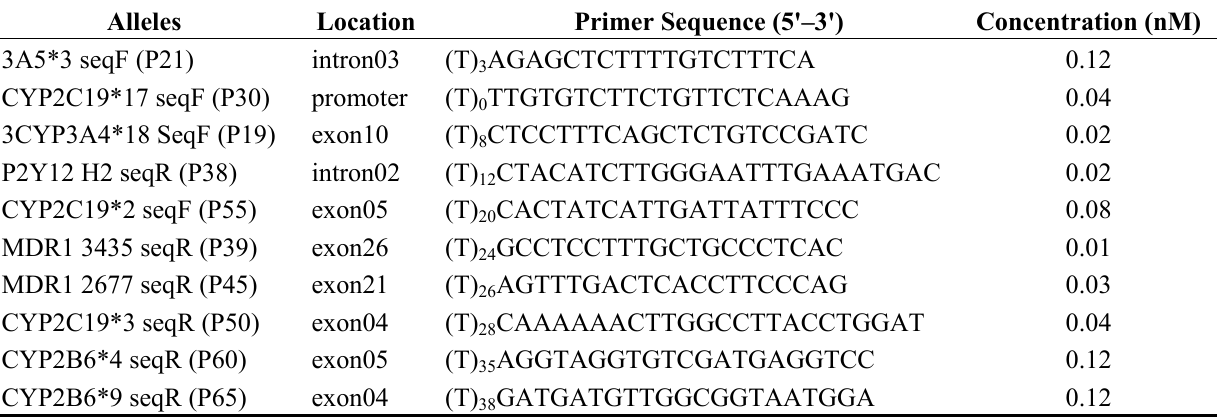
Table 2. List of sequencing probe used in the single-base extension.